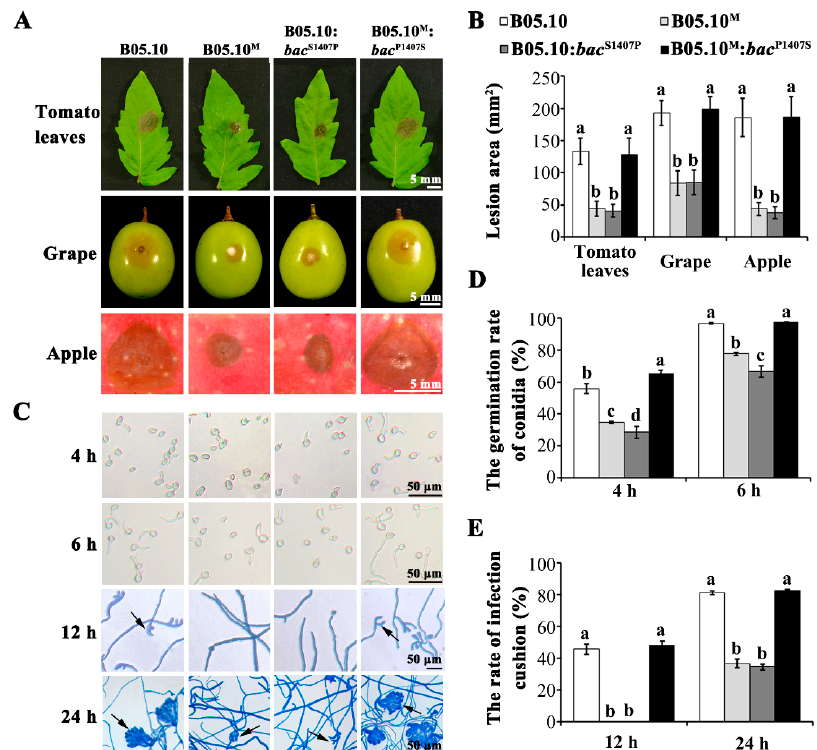
Figure 2. The single-nucleotide mutation in bac led to reduced virulence and decreased rates of spore germination and infection cushion formation. ( A ) Lesion formation on tomato leaves, grape and apple fruits inoculated with conidial suspensions (10 6 /mL) of B05.10, B05.10 M , B05.10: bac S1407P , and B05.10 M : bac P1407S . Disease symptoms on tomato leaves, grape and apple fruits were photographed at 48, 72, and 96 h after inoculation, respectively. Bar = 5 mm. ( B ) Area of lesions formed on tomato leaves, grape and apple fruits inoculated with four test fungi. ( C ) Spore germination and infection cushion formation. The infection cushions were stained with lactophenol cotton blue. Bar = 50 μ m. ( D , E ) Rates of spore germination ( D ) and infection cushion formation ( E ) of each strain shown in (C). Different letters on the columns in ( B ), ( D ) and ( E ) indicate significant differences ( p < 0.05); the same-colored columns in these graphs represent the same fungal strains shown in ( B ).